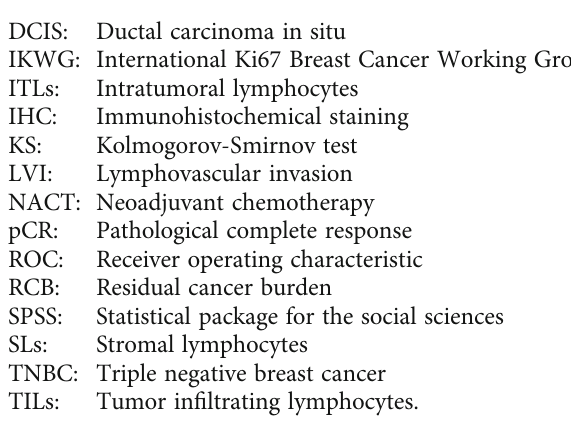
Table 1: distribution of demographic data, pathological fea- tures collected from pretherapy core biopsies and parame- ters investigated in the posttherapy specimens. Table 2: relation between categorical parameters in 153 breast cases and pCR (chi-square test). Table 3: relation between quanti- tative parameters in 153 breast cases and pCR (Mann – Whit- ney test). (Supplementary